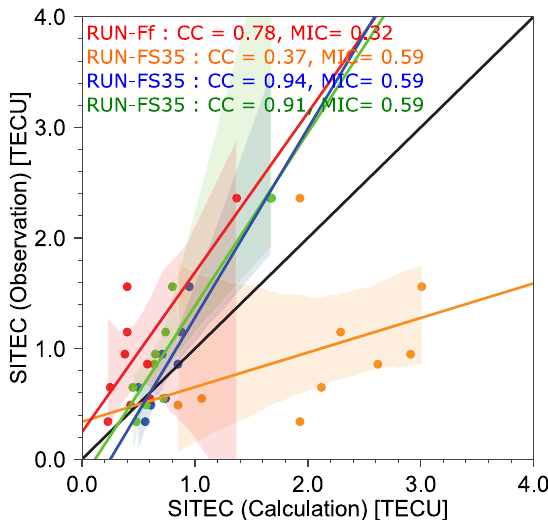
Fig. 8 Relationship between the observed and calculated SITEC for the events analyzed in this study. The relationship between the observed and calculated SITEC for the 9 flare events analyzed in this study. The results for RUN-Ff, RUN-FS35, RUN-FS15, and RUN-FS10 are plotted in red, orange, blue, and green, respectively. The dashed line shows the regression for each plot, and the black solid line shows a straight line with slope 1. For each regression line, 95% confidence intervals are shown in shading. The correlation coefficients (CC) and maximal information coefficient (MIC) are shown at the upper left, where the text color corresponds to the symbol